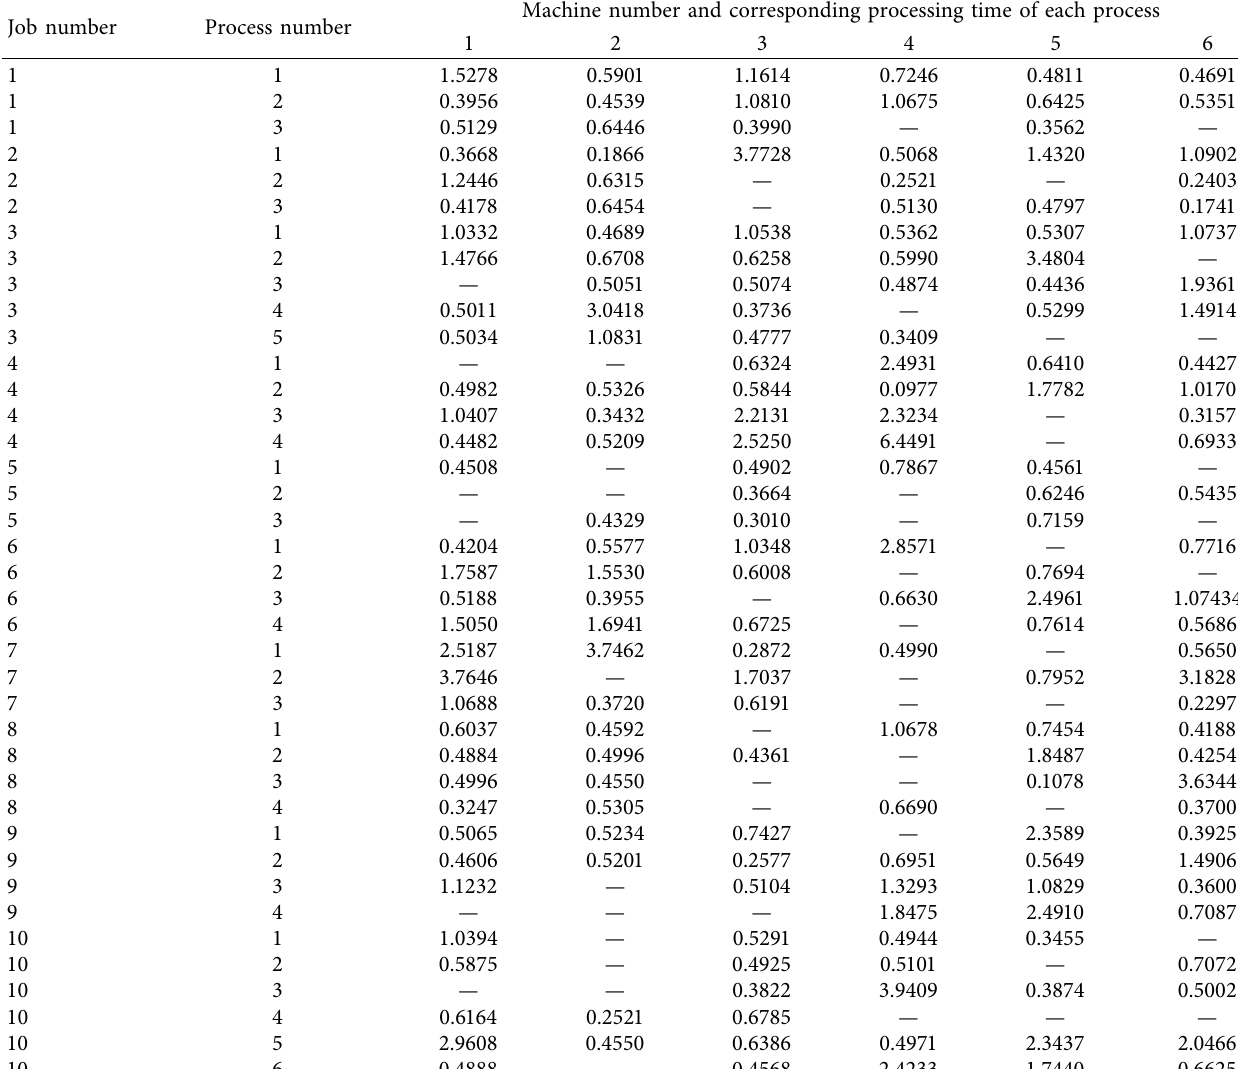
Table 2: Tasks to be processed at t � 0.